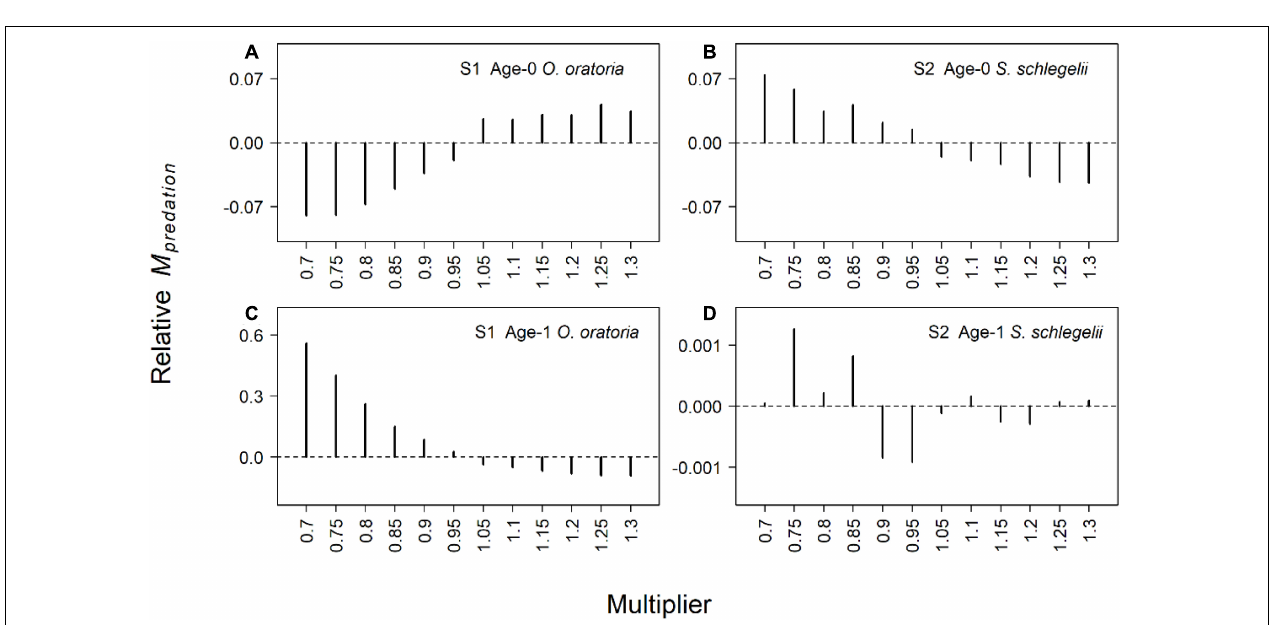
FIGURE 3 | Interannual changes of target species biomass under different fishing scenarios. Scenarios S1 and S2 considered O. oratoria and S. schlegelii as target species, respectively. The fishing mortality rate of each non-target species was set from 0.7 (Fx0.7) to 1.3 (Fx1.3) times the initial value with a step equal to 0.05.